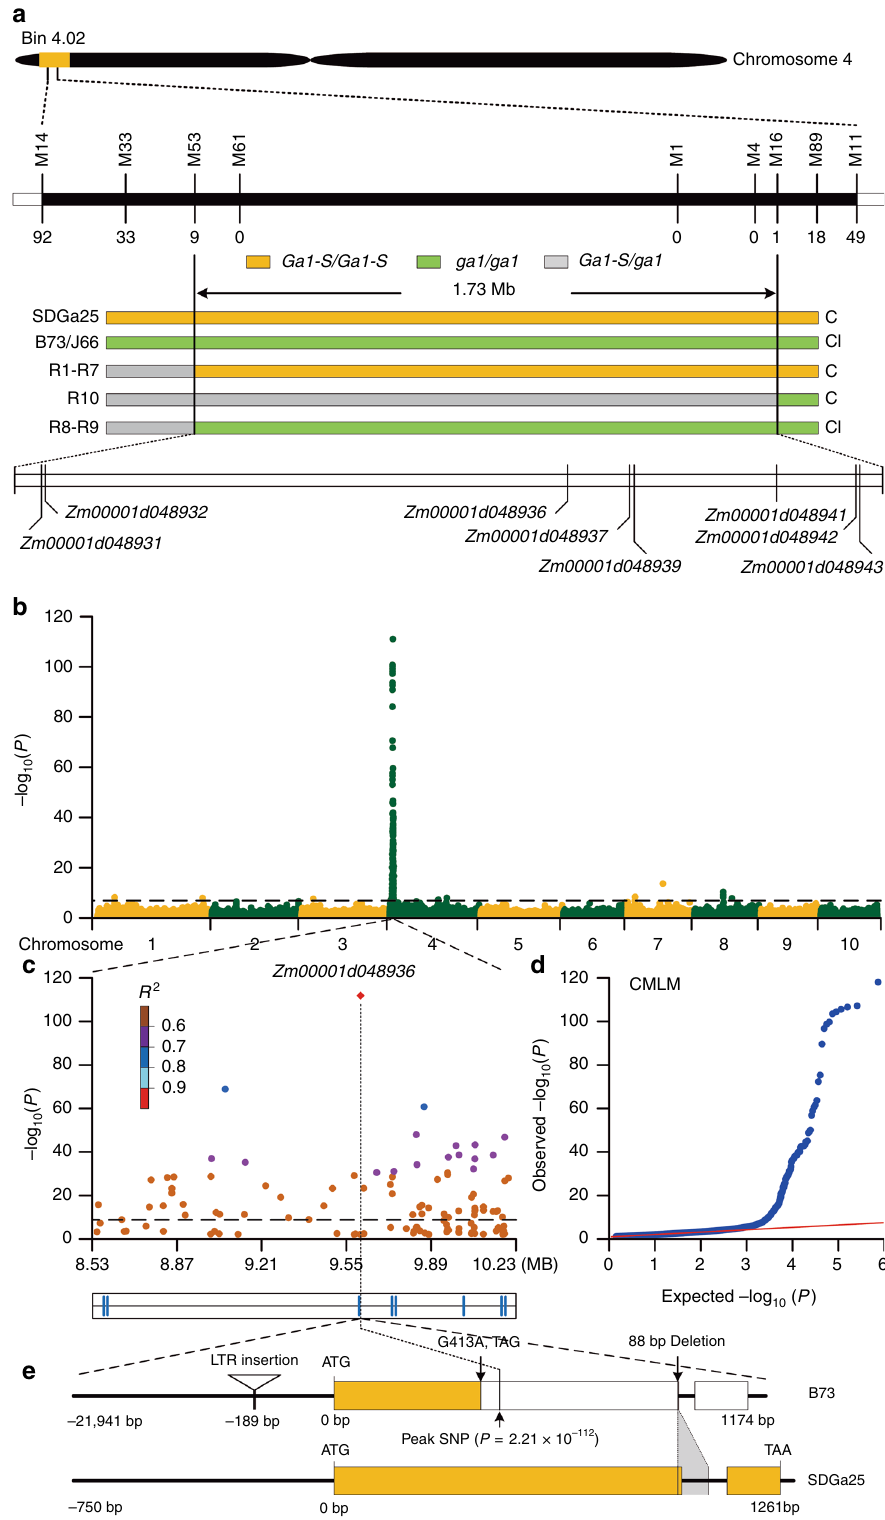
Fig. 1 Map-based cloning of the pollen determinant. a Physical mapping, showing Bin 4.02 narrowed to a region between markers M53 and M16 contains 8 annotated genes. Recombinants are indicated below the markers. R1-R10, recombinants. C, cross-compatible; CI, cross-incompatible. b Genome-wide association analysis of the pollen determinant. The horizontal dashed line depicts the Bonferroni-adjusted signi fi cance threshold ( P = 2.15 × 10 − 8 ). c The genome-wide association signals in the 8.53 – 10.23 Mb interval. The peak SNP is positioned by a vertical dashed line with a red diamond. The eight annotated genes are indicated by the blue bars at the bottom. d Quantile – quantile plot under a compressed mixed linear model. e Gene structure of Zm00001d048936 in B73 ( ga1 ) and SDGa25 ( Ga1-S